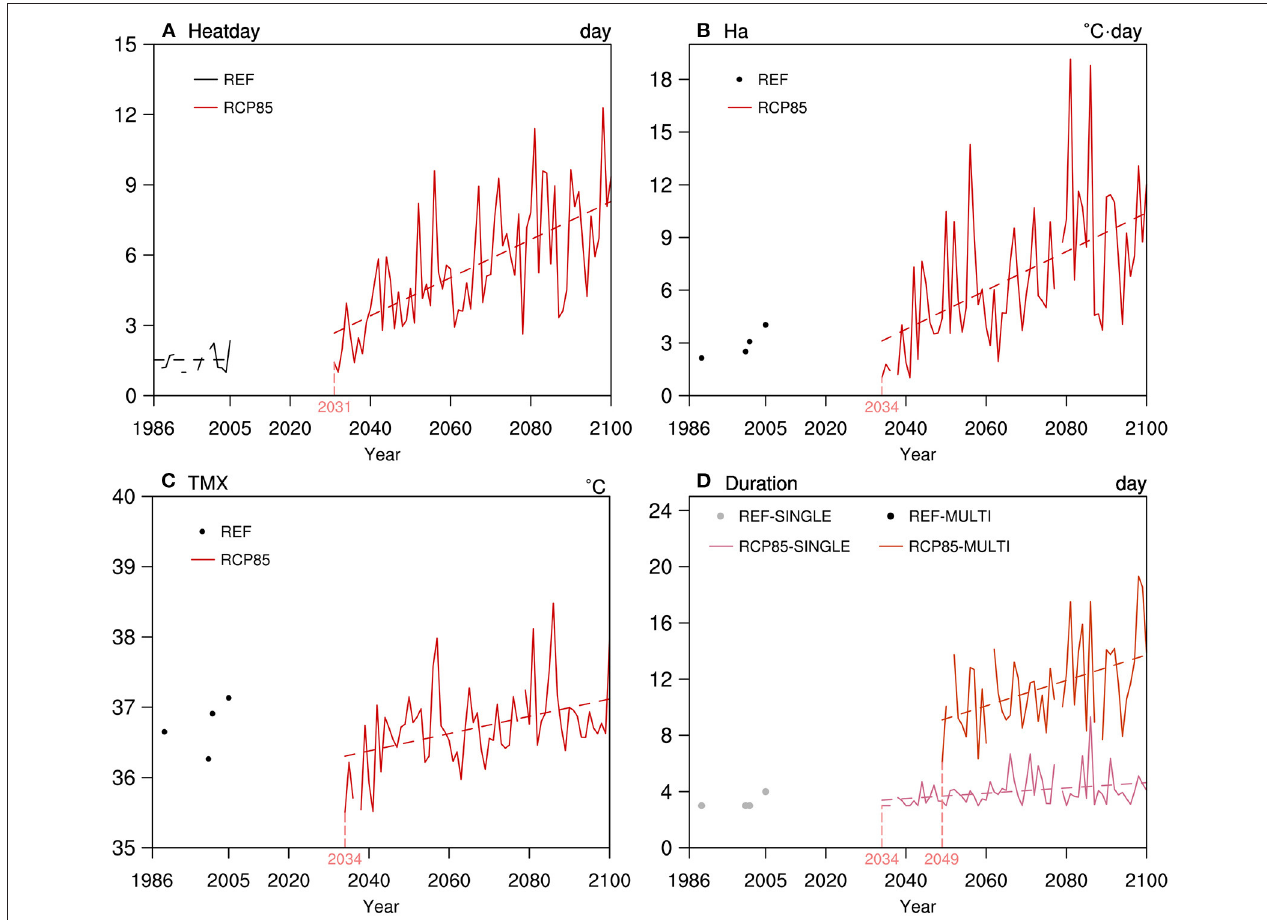
FIGURE 5 | Time series of (A) the number of high-temperature days (unit: day), (B) hazardous heat accumulation temperature (unit: ◦ C · day), (C) maximum temperature in the process of heat damage (unit: ◦ C), (D) single- and multiple process durations of heat damage (unit: day) simulated and projected by LMDZ-MME averaged over Northeast China. The reference time period is 1986–2005, and for future projection, the time period of 2006–2100 is taken under the emission pathway of RCP8.5. The black and gray dots, and gray dotted line denote the historical simulation results. The red and magenta solid lines denote the multimodel projections under RCP8.5 pathway. In the plot, all the long dashed lines are for the linear regressions of different indexes with the vertical magenta short lines and corresponding years indicating the first occurrence times of individual hot extreme